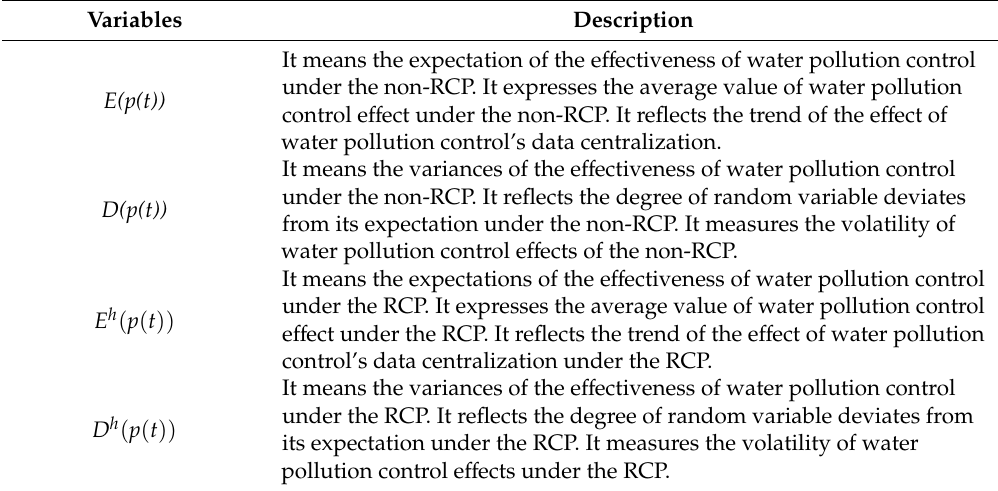
Table A4. Variables and descriptions.